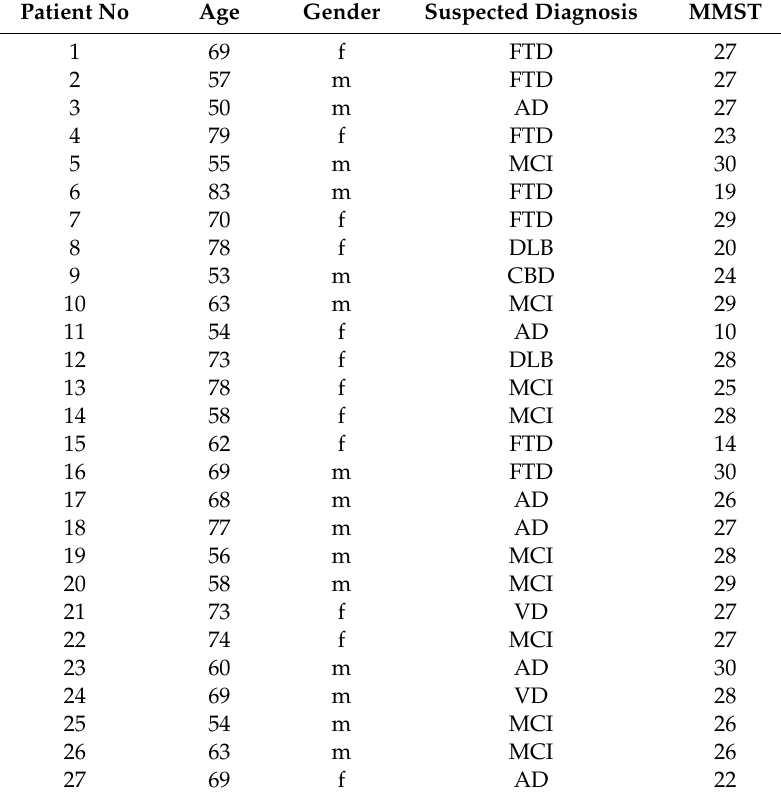
Table 1. Patients’ clinical